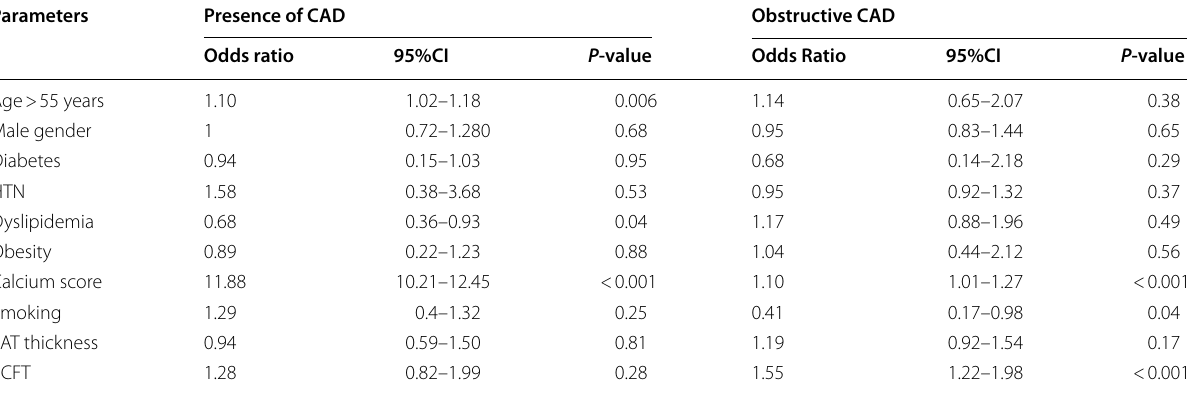
CAD , coronary artery disease; EAT , epicardial adipose tissue; PCFT , Pericoronary fat thickness; HTN , hypertension